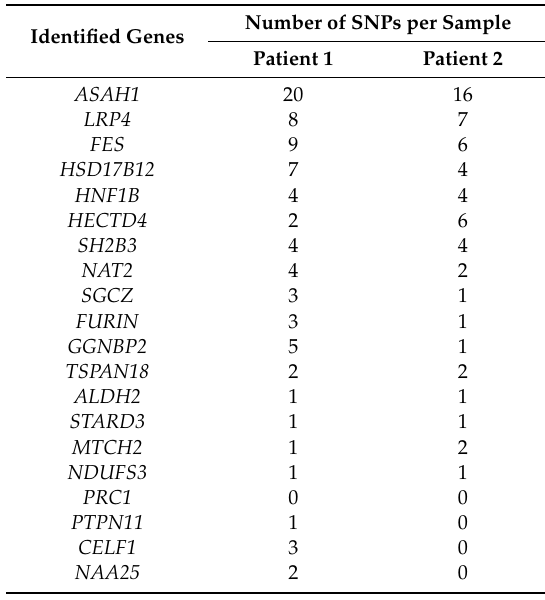
Table 5. List of SNPs identified by next-generation sequencing (NGS) from two diabetic patients in genes located in the shared chromosomal